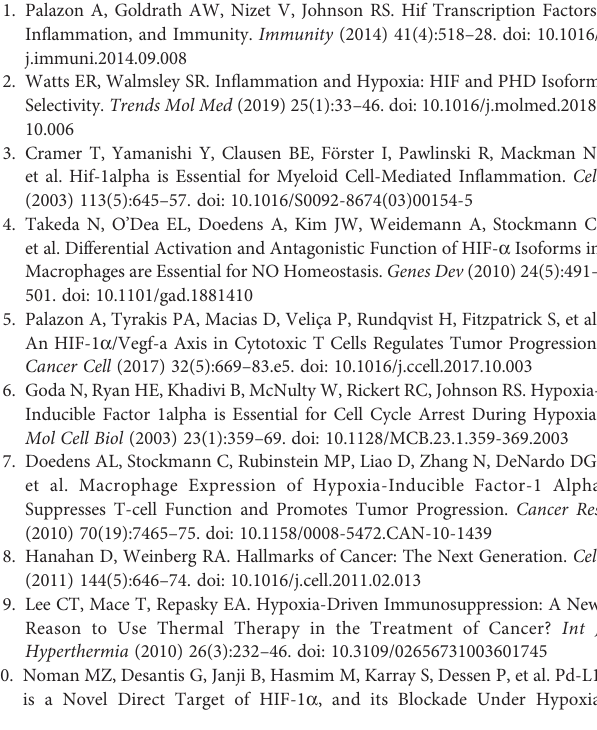
Supplementary Figure 2 | Human monocyte compound induced hypoxia alters expression of human CD8 + T-cell activation markers. (A) Representative gating strategy used to analyze monocyte surface markers followed by scatter dot plots and representative histograms of CD25 and CD16 surface expression of monocytes with or without LPS treatments. Statistical analysis was performed with (donor) paired T-test. (B) Representative gating strategy used to analyze CD8 + T-cell division and expression of different surface markers. (C) Expression of CD45RO and (D) CD45RA as log2fold change in CD8 + T-cells from different conditions and treatments. Data presented as violin plots or representative histograms, *P< 0.05, **P< 0.01, ***P<0.001; ns, not signi fi cant. Statistical analysis was performed with Two-way RM ANOVA and Tukey ’ s multiple comparisons test, n = 6 blood donors/group. All samples were standardized to untreated single cultured donor matched CD8 +